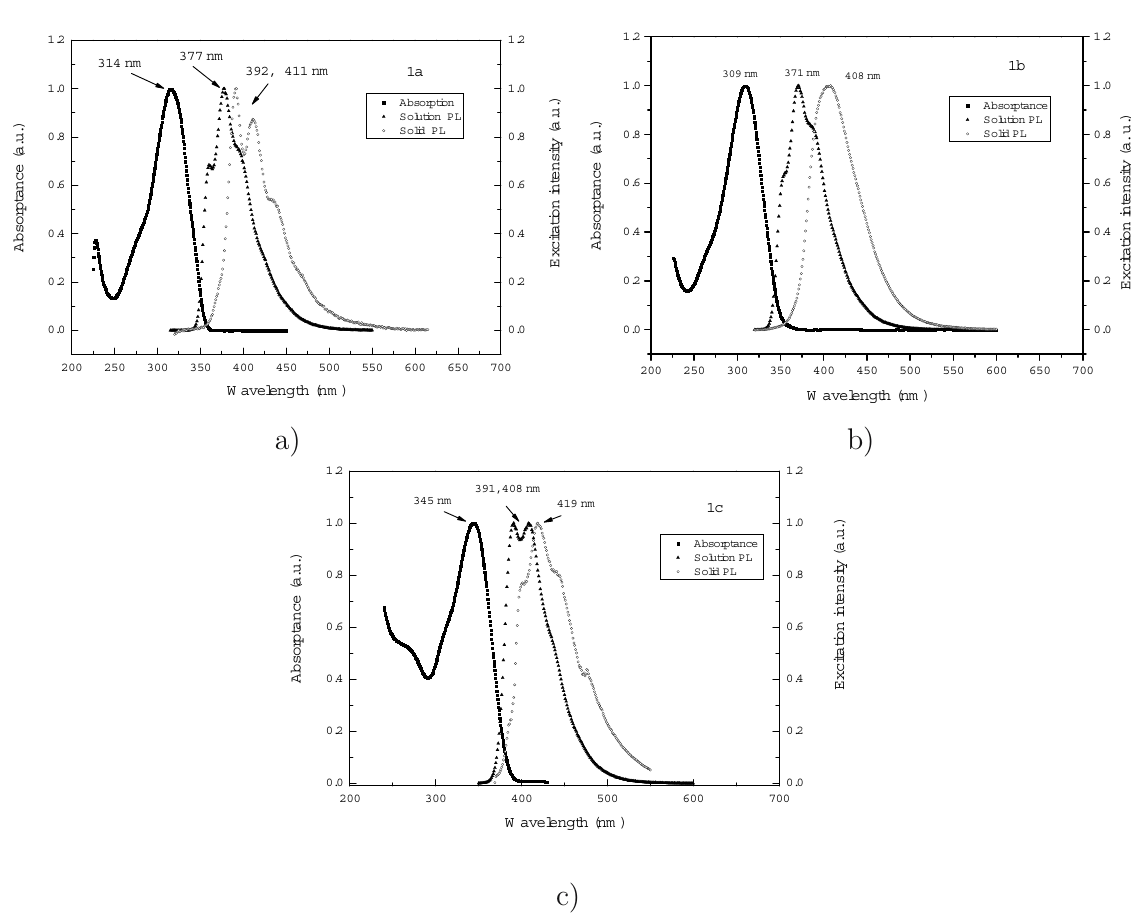
Fig. 3 The UV absorption and PL spectra of 1a (a), 1b (b) and 1c (c). Fluorescence quantum yields (Φ ) of 1a-c in solution (using quinine sulfate as stan- f SO ) are found to be extremely high at 98 %, 97 % and 99%, dard sample in 0.05 M H 2 4